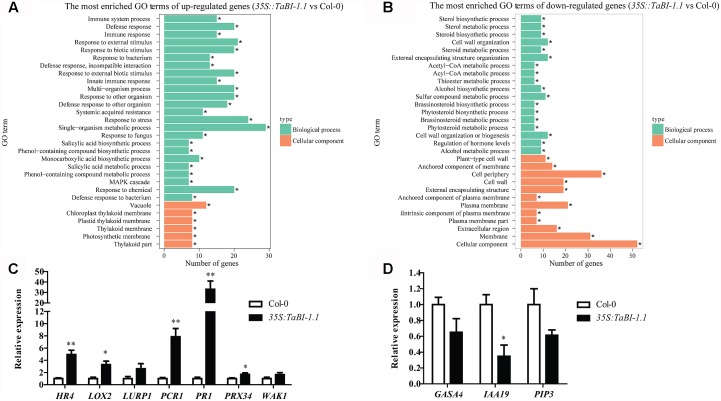
The enrichment of GO terms for genes that were differentially expressed between 35S::TaBI-1.1 and Col-0 was analyzed using RNA-seq. The most enriched GO terms of up-regulated genes (A) and down-regulated genes (B) in 35S::TaBI-1.1 compared with Col-0 (35S::TaBI-1.1 vs. Col-0). Vertical coordinates represent enriched GO terms, and horizontal coordinates represent the numbers of differentially expressed genes for these GO terms. The green columns represent the GO terms for biological processes, and the orange columns represent the GO terms for cellular components. The asterisk “∗” indicates significantly enriched GO terms. (C) qRT-PCR analysis of seven up-regulated genes in 35S::TaBI-1.1 vs. Col-0. (D) qRT-PCR analysis of three down-regulated genes in 35S::TaBI-1.1 vs. Col-0. Vertical coordinates represent fold changes, and horizontal coordinates represent different genes. The relative expression levels of 10 genes in Col-0 were set to “1.” Arabidopsis actin2 was used as a reference. Error bars indicate the SDs. The data represent the means ± SD of three biological replications. Asterisks (∗ and ∗∗) indicate significant differences (P < 0.05 and P < 0.01) compared with Col-0 (Student’s t-test).